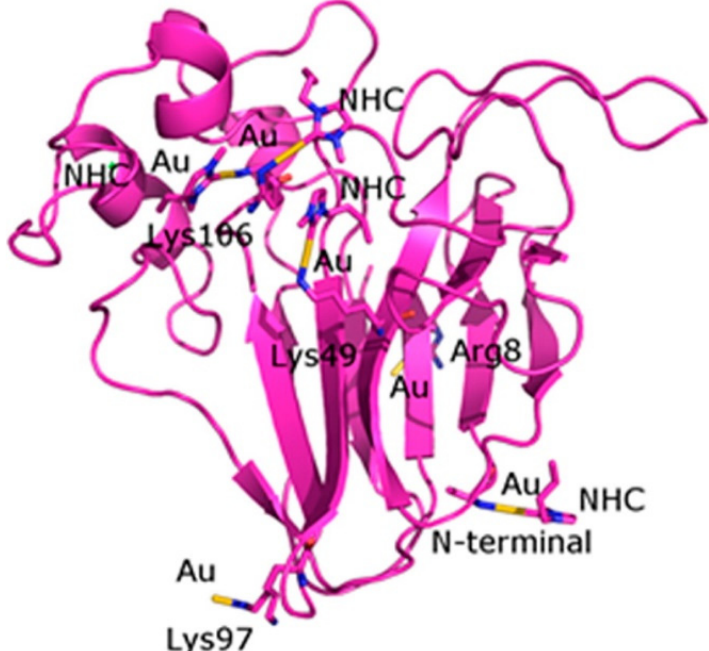
Figure 1. Overall structure of thaumatin-Au(NHC)Cl (with NHC = 1-butyl-3-methyl-imidazole-2- ylidene) (Reprinted with permission from ref. [19] Copyright © 2016 American Chemical Society).